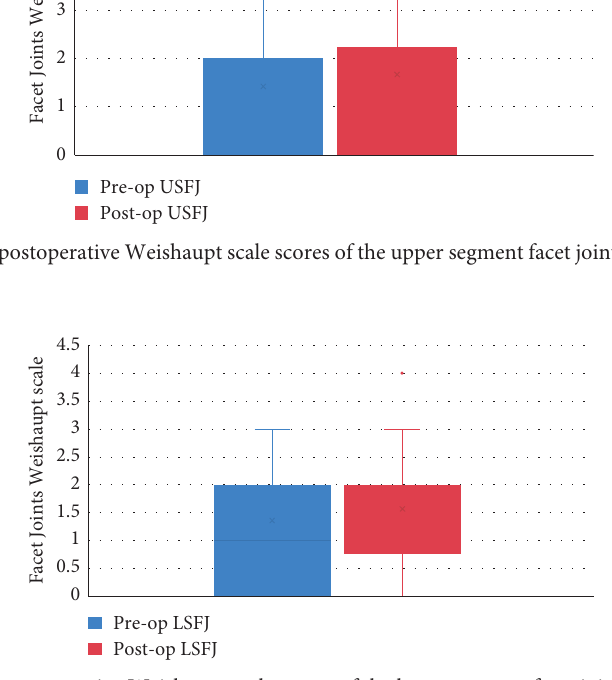
Figure 4: Preoperative and 1-year postoperative Weishaupt scale scores of the lower segment facet joints. LSFJ, lower segment facet